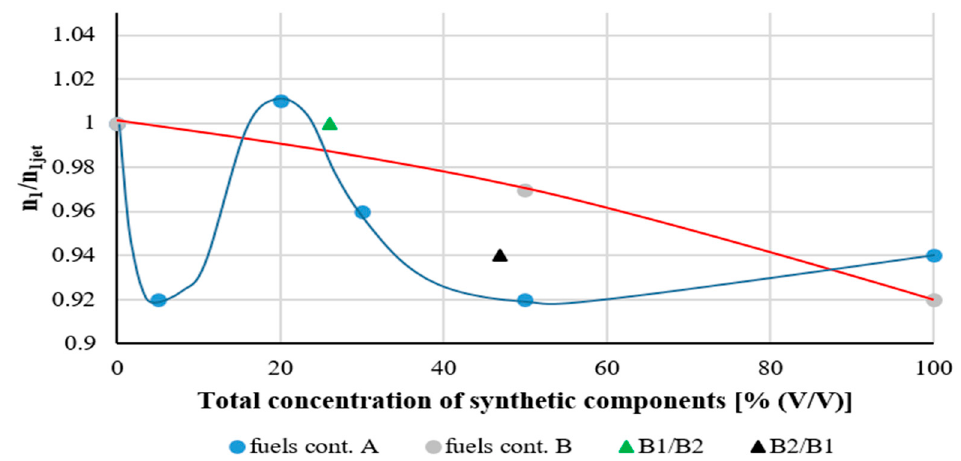
Figure 11. Dependences a 11 /a 11Jet and n 1 /n 1Jet on the total concentration of synthetic components A and B.